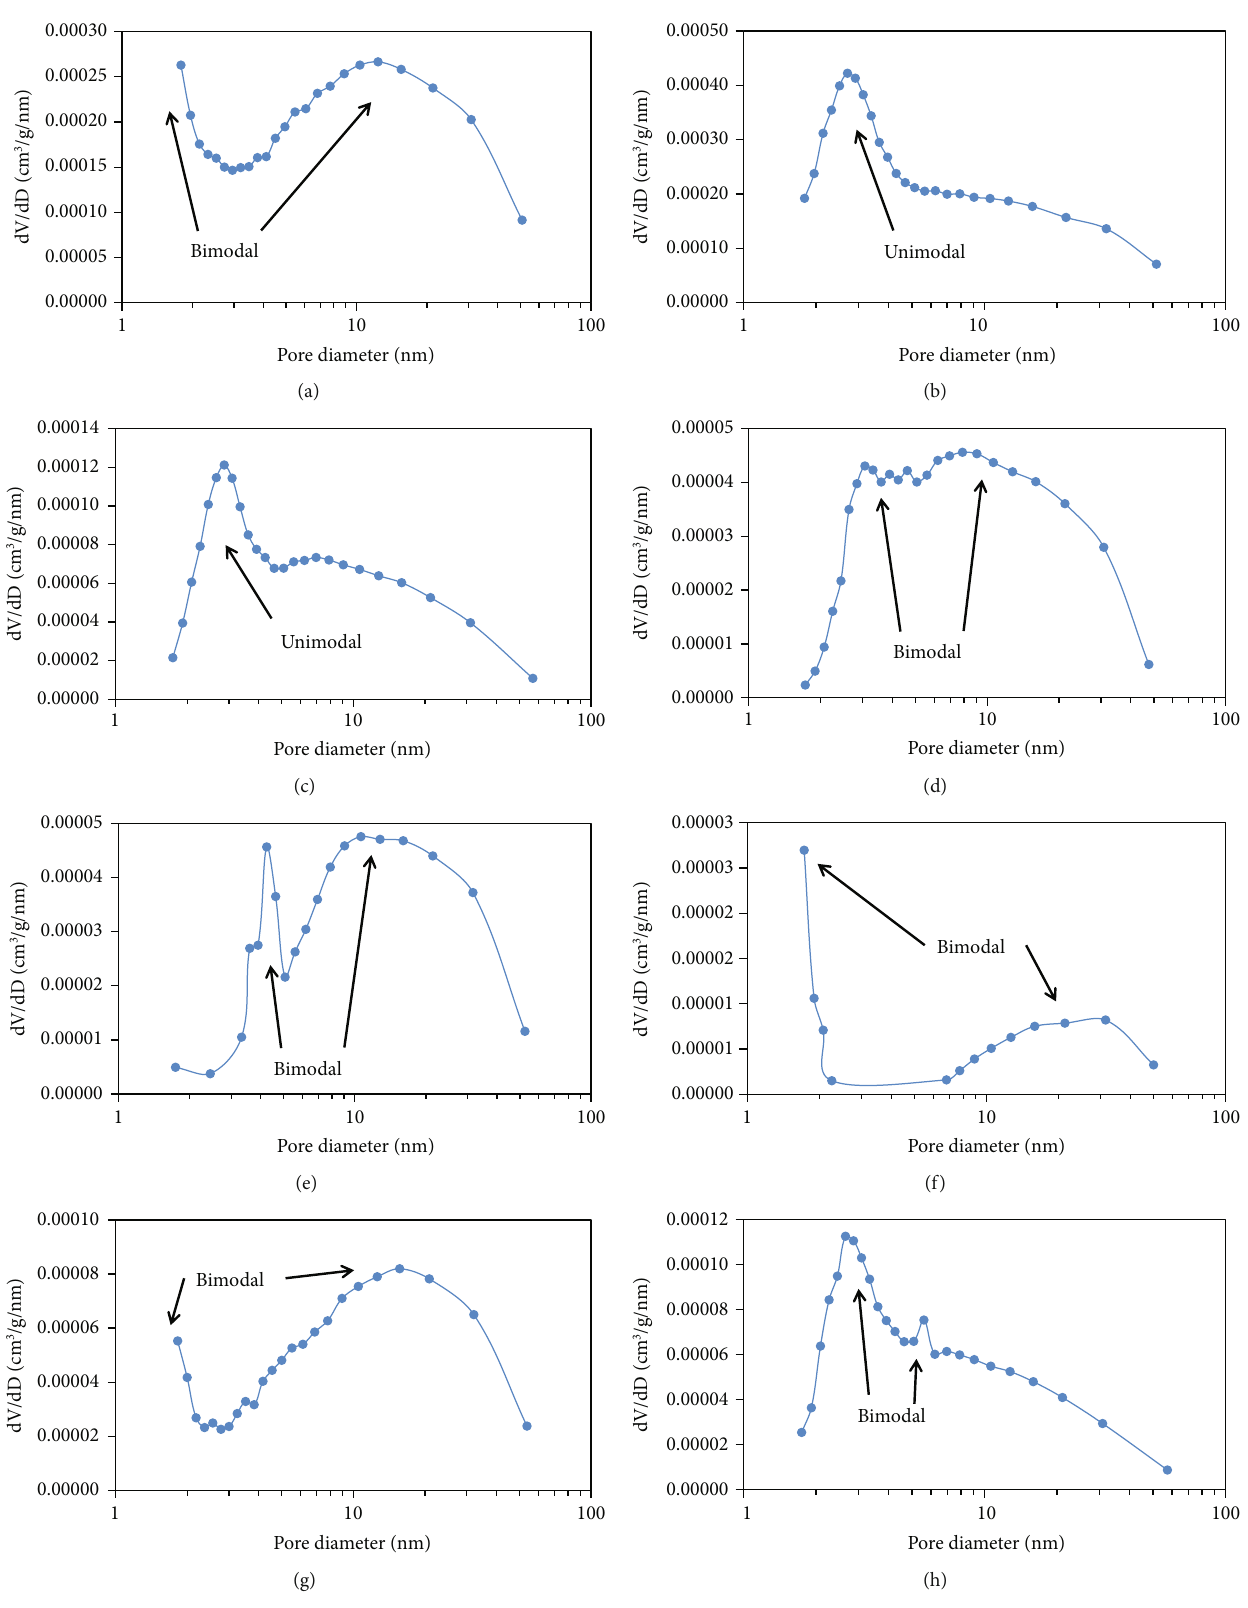
Figure 6: Pore-sized distribution of tight reservoir samples from the Palaeogene Xiaganchaigou Formation samples measured by low adsorption. (a) MSCSs-1. (b) MSCSs-2. (c) MSCSs-3. (d) MSCSs-4. (e) MSCSs-5. (f) MSCSs-6. (g) MSCSs-7. (h) pressure N 2